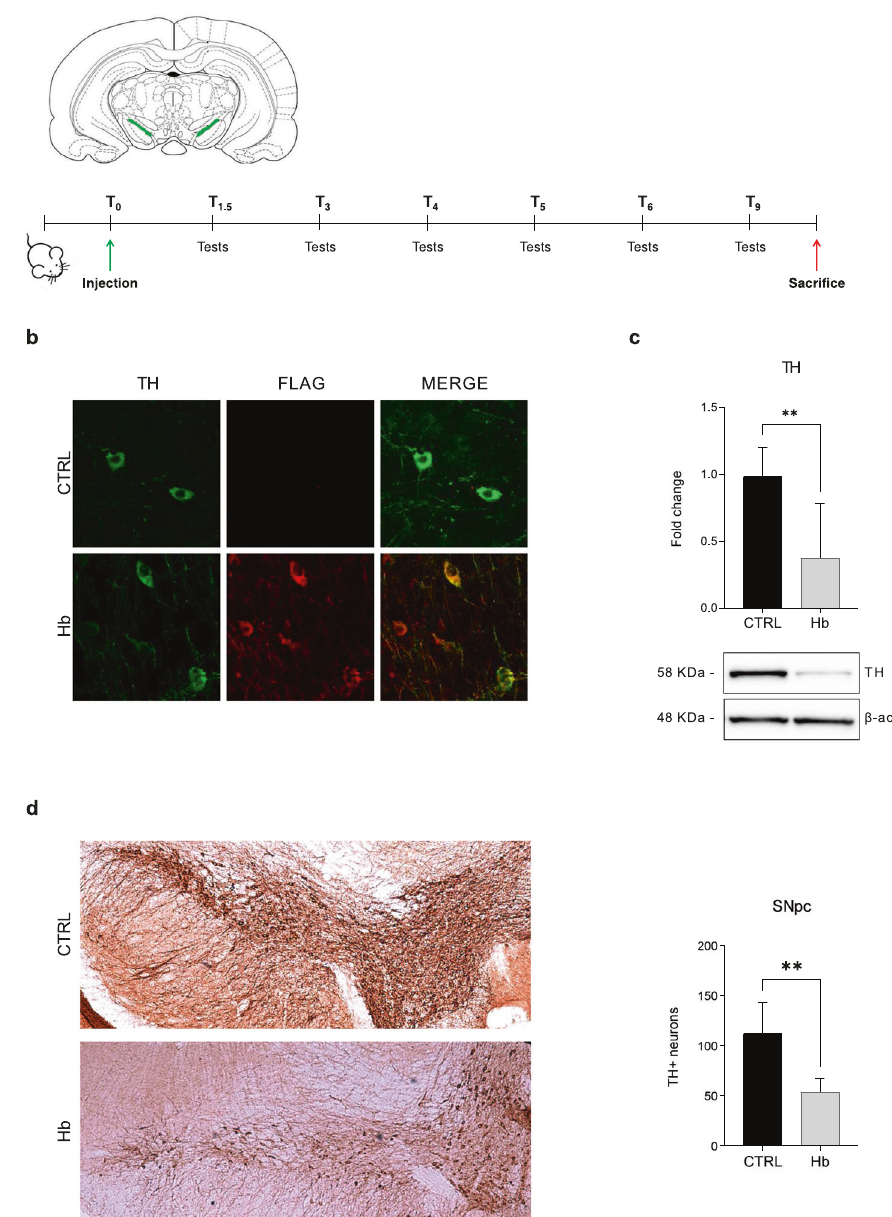
Fig. 1 Hb overexpression in SNpc triggers the loss of DA neurons. Scheme representing the experimental protocol used for the assessment of Hb overexpression. AAV9 expressing Hb (Hb) and CTRL (CTRL) constructs were bilaterally injected in the brain of 3-month-old mice. Brain diagram indicating SNpc (green) as the region of the injection (upper panel). Behavioural tests were performed to verify the locomotor performance of mice 1.5, 3, 4, 5, 6 and 9 months post-injection (lower panel) ( a ). Co-localization of FLAG-Hb in DA TH + neurons ( b ). The level of expression in SNpc of Hb and CTRL mice ( n = 4) at 10 months post-injection of tyrosine hydroxylase (TH, 58 KDa) was assessed by Western blot ( c lower panel). Band intensity was quanti fi ed ( c upper panel). TH-positive neurons of the SNpc were evaluated by immunohistochemistry ( d left panel) and quanti fi ed ( d right panel) for Hb and CTRL mice ( n = 4; 3 slices each). Data represent means ± SEM. Statistical analysis was performed with unpaired t-test with Welch ’ s correction. * p ≤ 0.05; ** p ≤ 0.01; *** p ≤ 0.001; **** p ≤ Hb triggers the accumulation of a C-terminal truncated form of α -syn in vitro Hb and control cells were then treated with 2 μ M PFFs for 24, 48, and 96 h and the pattern of α -syn species was studied by Western blot analysis using SYN-1 or C-20 antibodies. In general, the intracellular expression of FL- α -syn decreased over time, whereas Δ C- α -syn species increased (Fig. 4c, d). Notably, Δ C- α -syn was reproducibly more abundant in Hb than CTRL cells at each time point and the levels of Δ C- α -syn normalized to FL- α -syn ( Δ C- α -syn/FL- α -syn ratio)